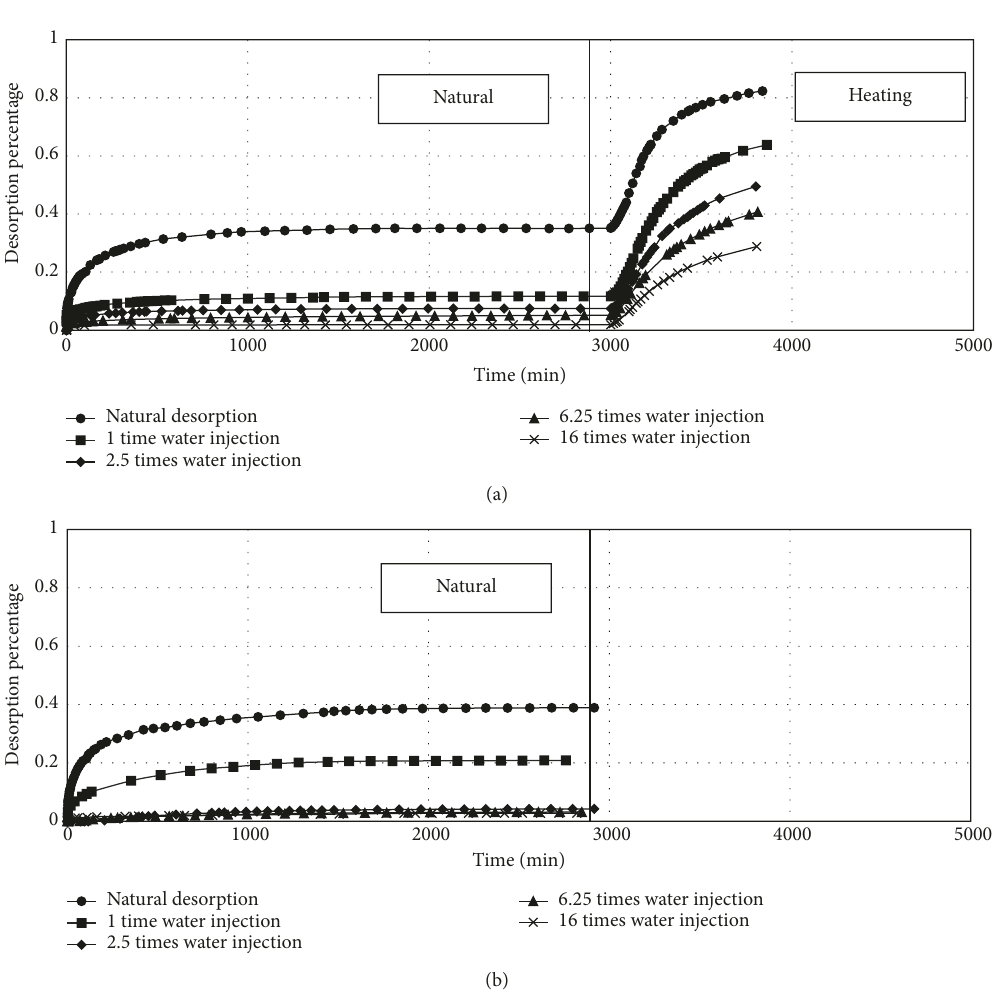
Figure 3: Desorption capacity versus time in different water injection pressures at 0.25MPa gas adsorption pressure. (a) Coal sample #1 (Gucheng Coal Mine). (b) Coal sample #2 (Gaohe Coal